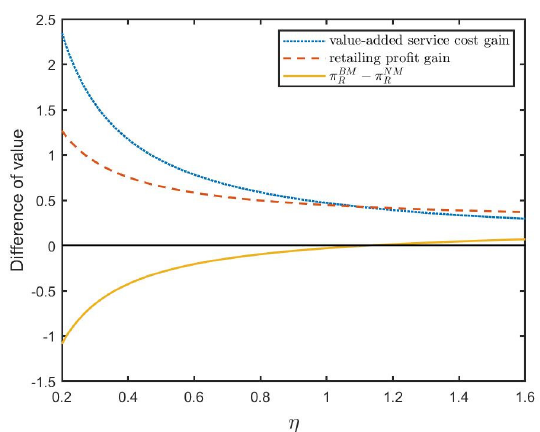
Figure 5. Impact of η on the retailer in Model iM ( i = N , B ) . ( α = 2.2, σ = 0.2, φ =